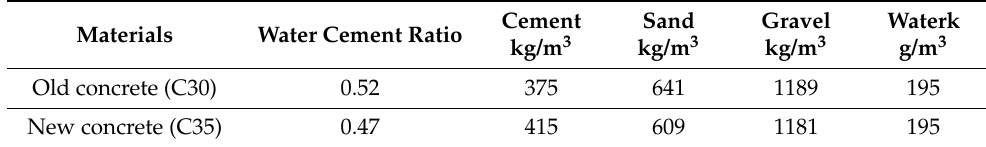
Table 1. Concrete composition of the old concrete and new